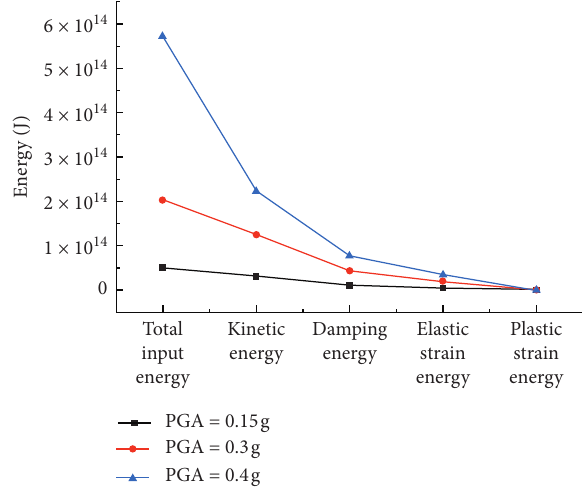
Figure 8: Accumulated values of the energy with different PGAs.